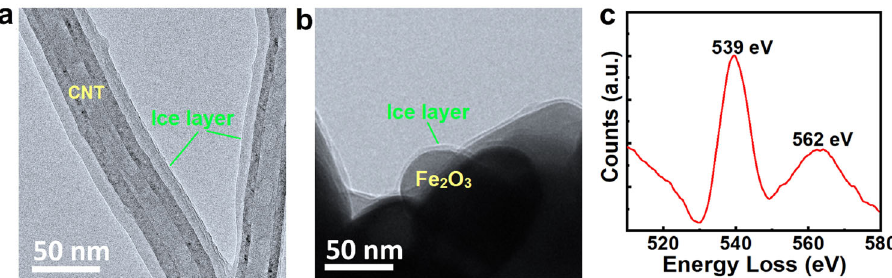
Fig. 2 Nanoscale water fi lm formation. a CryoEM image of ice layer on CNTs. b CryoEM image of ice layer on IOPs. c EELS spectrum showing oxygen peaks characteristic of ice layer in a .